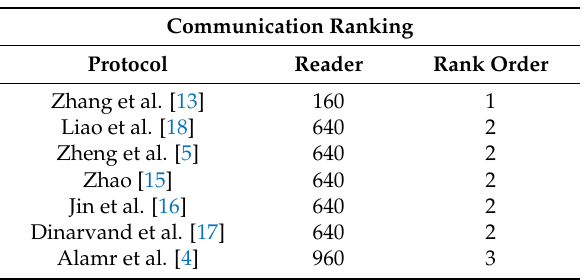
Table 9. Ranking based on reader/server to tag communication cost.